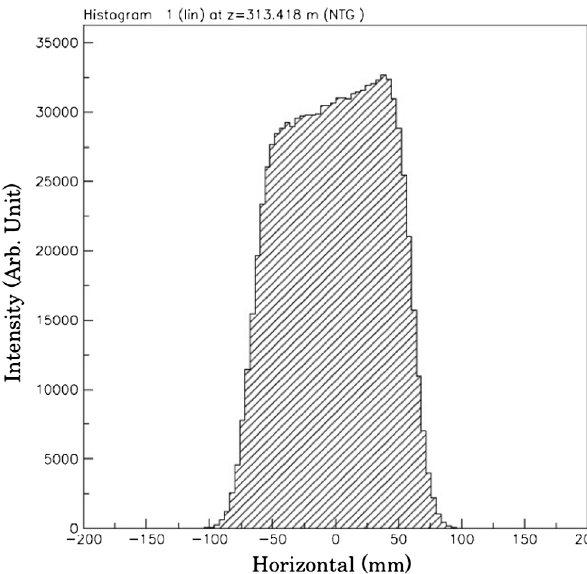
FIG. 18. Horizontal beam profile at neutron production target for 2 mm horizontal beam offset at the octupole magnet for horizontal focus (OCT2).